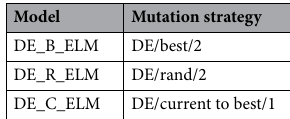
Figure 10. Comparison of models.